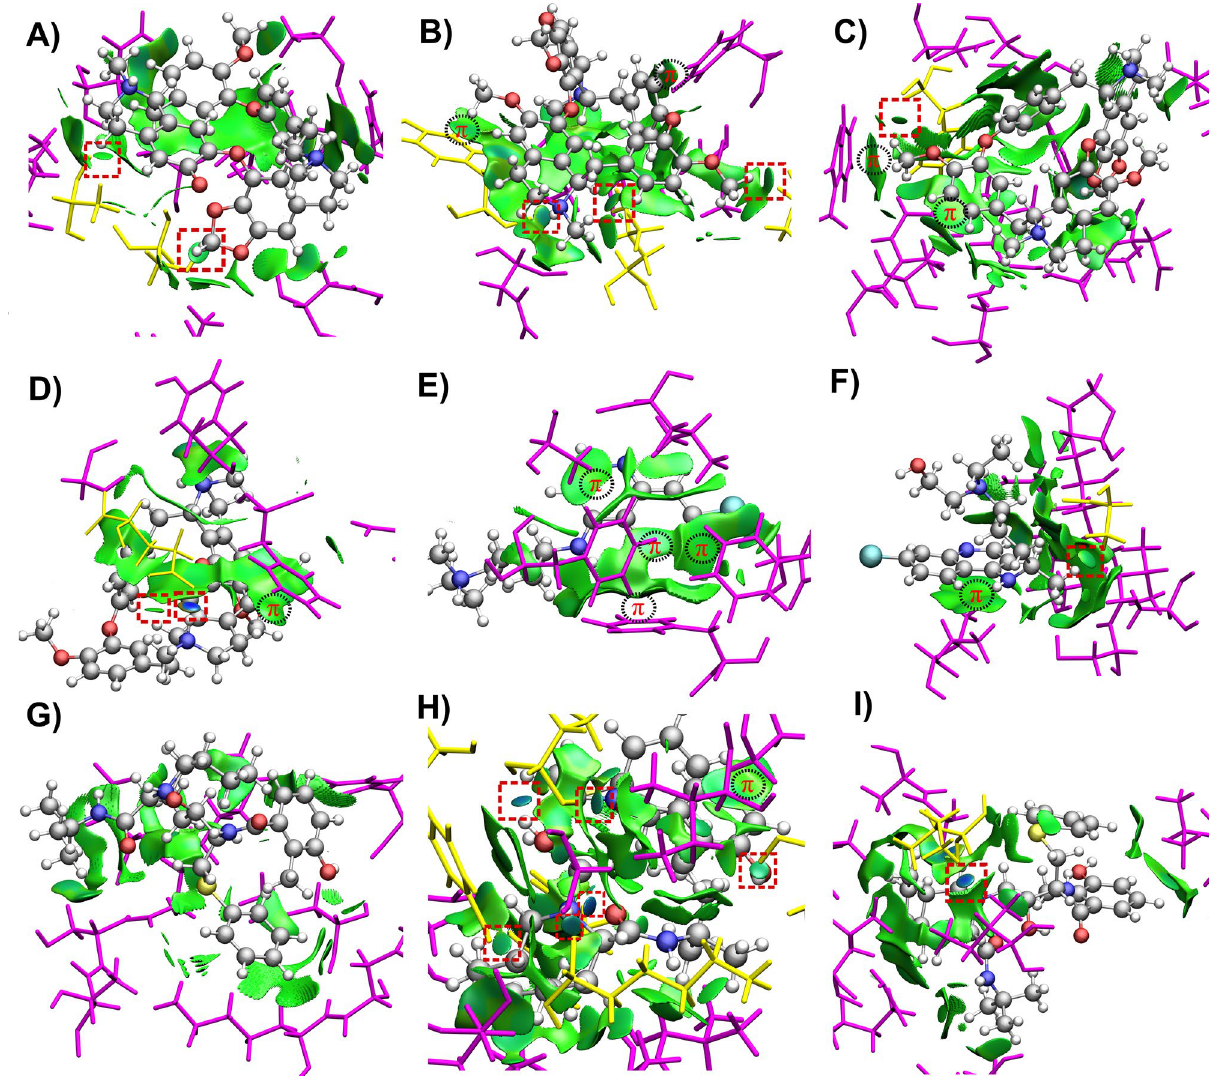
Figure 7. The NCI isosurfaces (drawn at 0.5) of ( A ) Cepharanthine-D614G, ( B ) Cepharanthine-H49Y, ( C ) Cepharanthine-T573I, ( D ) Cepharanthine-WT, ( E ) Hydroxychloroquine-H49Y, ( F ) Hydroxychloroquine- T573I, ( G ) Nelfinavir-H49Y, ( H ) Nelfinavir-T573I and ( I ) Nelfinavir-WT complexes. Blue and green regions represent strong attractive and weak dispersive interactions, respectively. The localized interactions are marked in a red square. The regions of π-interactions are also indicated. The amino-acid residues forming localized and delocalized interactions with the ligand are depicted in yellow and magenta,